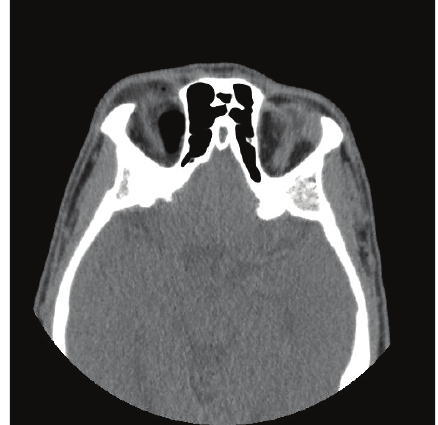
Figure3:Diffuseintraconal/preseptalairandsevereproptosisofthe right eye resulting in tenting of the optic globe and stretching of the optic nerve.